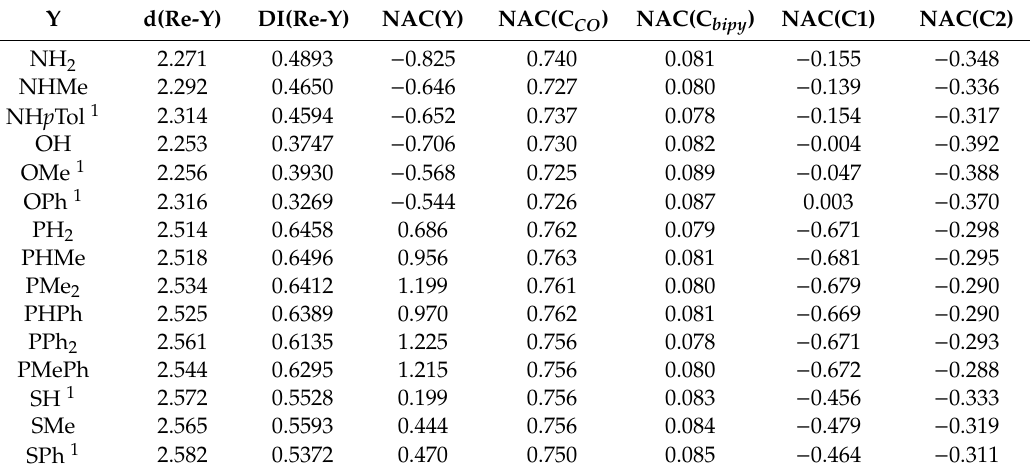
Table 3. Bond distances between Re and the heteroatom of the Y ligand (d(Re-Y) in Å), electron delocalization indexes at the bond critical points located between Re and Y (DI(Re-Y)), and net natural atomic charges of the nucleophilic atom of the Y ligand, the attacked carbon of the carbonyl ligand in cis disposition to the Y ligand, the attacked non-substituted ortho carbon of the bipy ligand, the non-substituted acetylenic carbon, and the substituted acetylenic carbon (NAC(Y), NAC(C CO ), NAC(C bipy ), NAC(C1), and NAC(C2) in e , respectively) at the intermediate I1 (cid:48) when Y = NH 2 ,